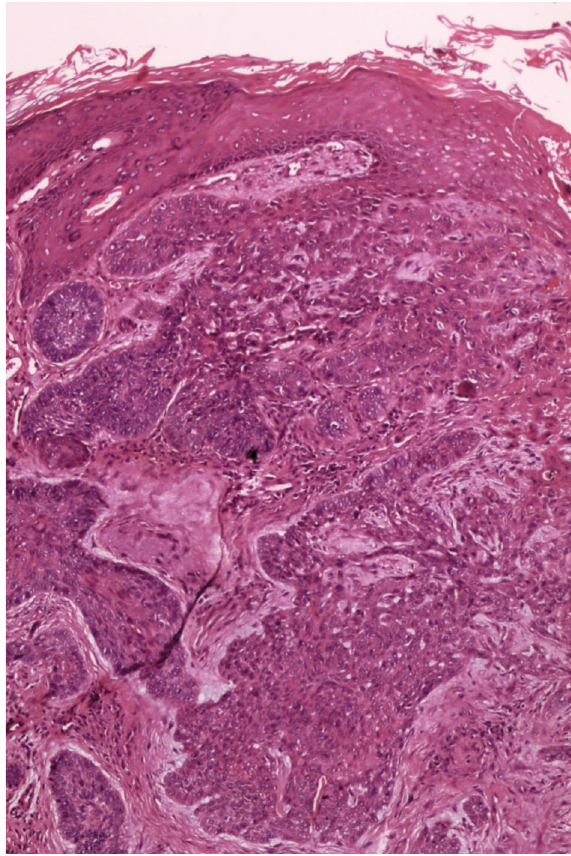
Figure 2: Basal cell carcinoma. Nests of basaloid cells project from the overlying epidermis (H&E, ×